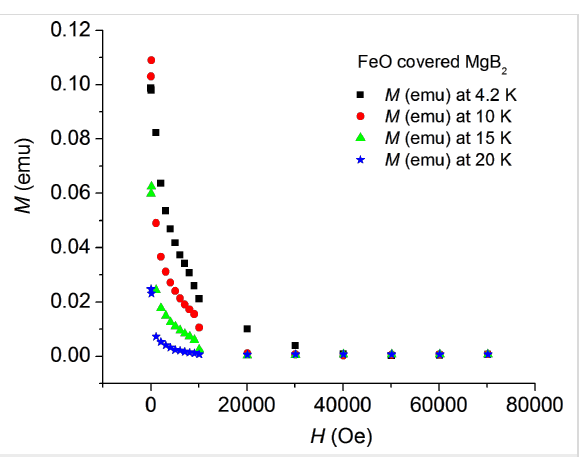
Figure 4: Magnetic-field dependence of the critical current density J c for the pure (red triangles) and for the FeO-covered (blue squares) MgB 2 samples at 10 K.